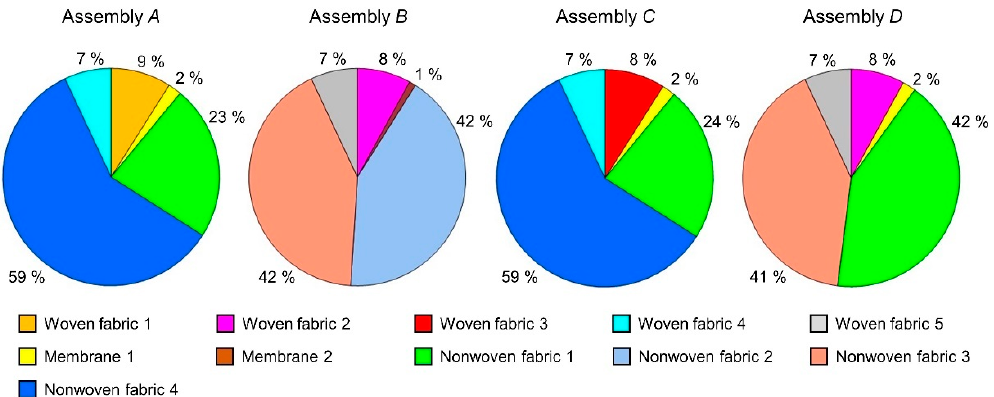
Figure 11. Percentage heat loss in layers of four tested assemblies.